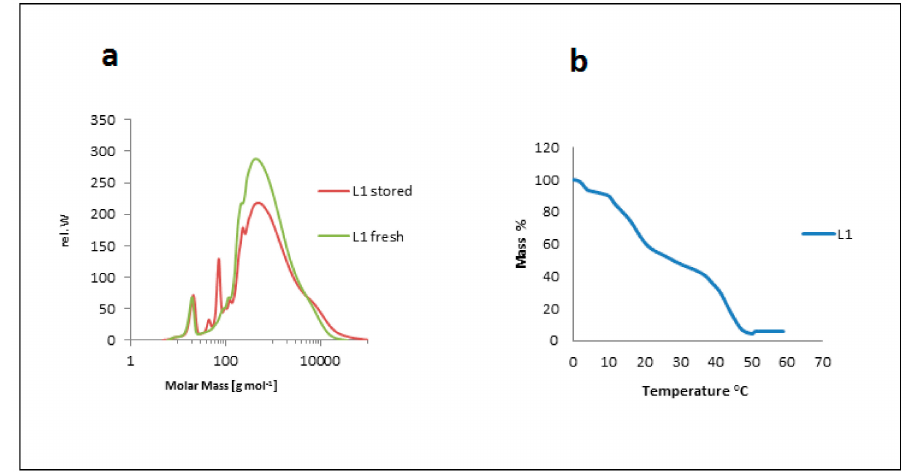
Figure 14. ( a ) Storage effect on lignin structure via SEC analysis of freshly isolated (green) versus stored (red) lignin (sample L1). ( b ) Temperature effect on the structure of lignin via TGA of kraft lignin (sample